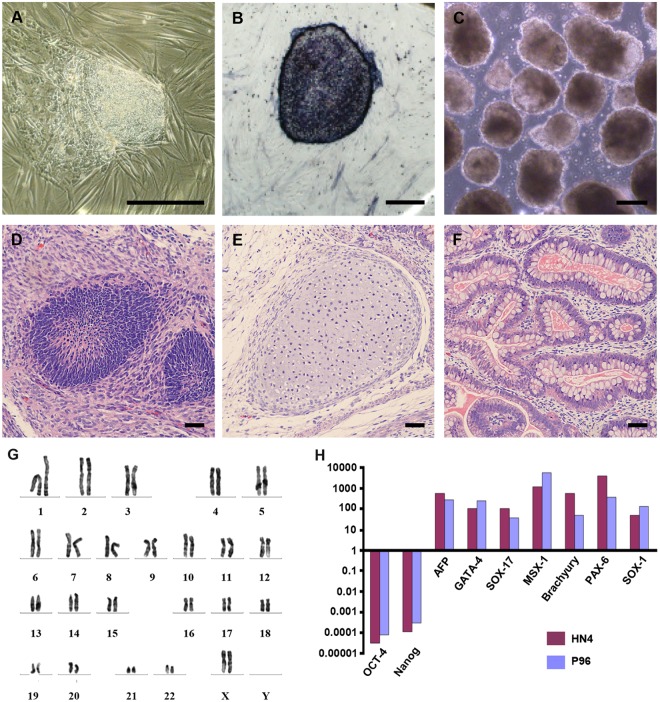
Generation and identification of P96 human embryonic stem cell (hESCs) line.
(A) A primitive colony of P96 cell line on day 4 after secondary isolation. Scale bars = 200 μm. (B) Alkaline Phosphatase staining of P96 cell line colony. Scale bars = 200 μm. (C) Embryoid body formation to detect totipotent potential of P96 cell line in vitro. Scale bars = 500 μm. (D–F) H and E staining of the teratomas formed by P96 cell line for 28 passages. The hESCs could be differentiated into three different germ layers: endoderm (D), mesoderm (E), and ectoderm (F). Scale bars = 200 μm. (G) A normal karyotype analysis of P96 cell line at the passage 25 (46, XX). (H) Real time RT-PCR to detect the makers of three different germ layers from HN4 and P96 cell line. ESC markers (OCT-4, Nanog); Endoderm markers (AFP, GATA-4, SOX-17); Mesoderm markers (MSX-1, Brachyury); Ectoderm markers (PAX-6, SOX-1).